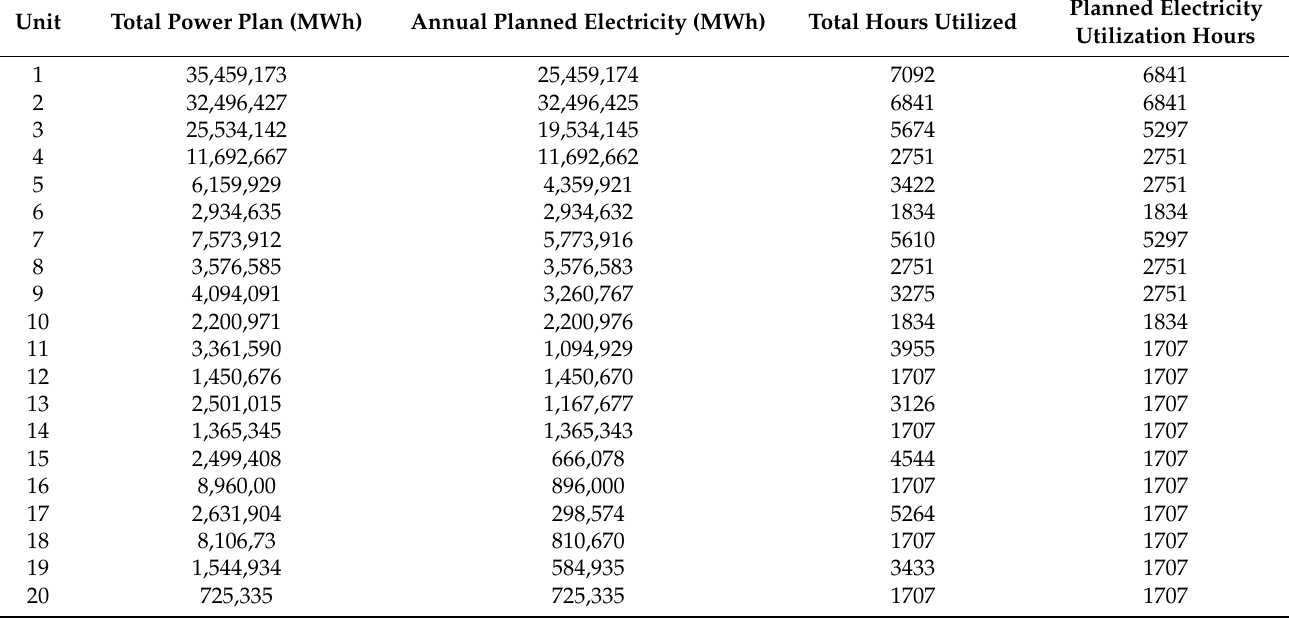
Table A6. Aunal electricity energy scheduling results under the basic case study